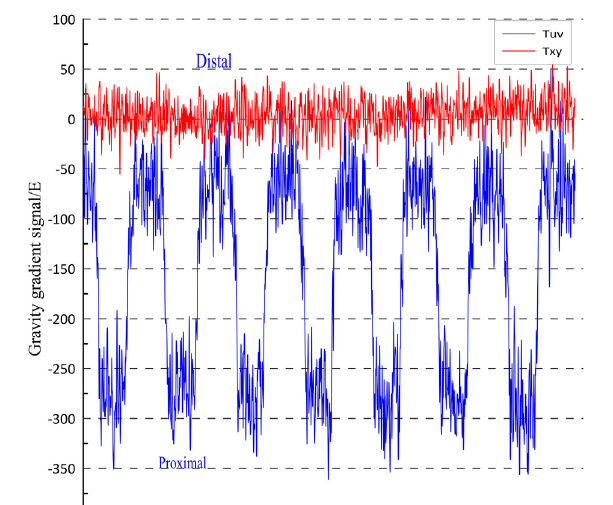
TABLE 3 Dynamic test sway spectrum of GGMS.